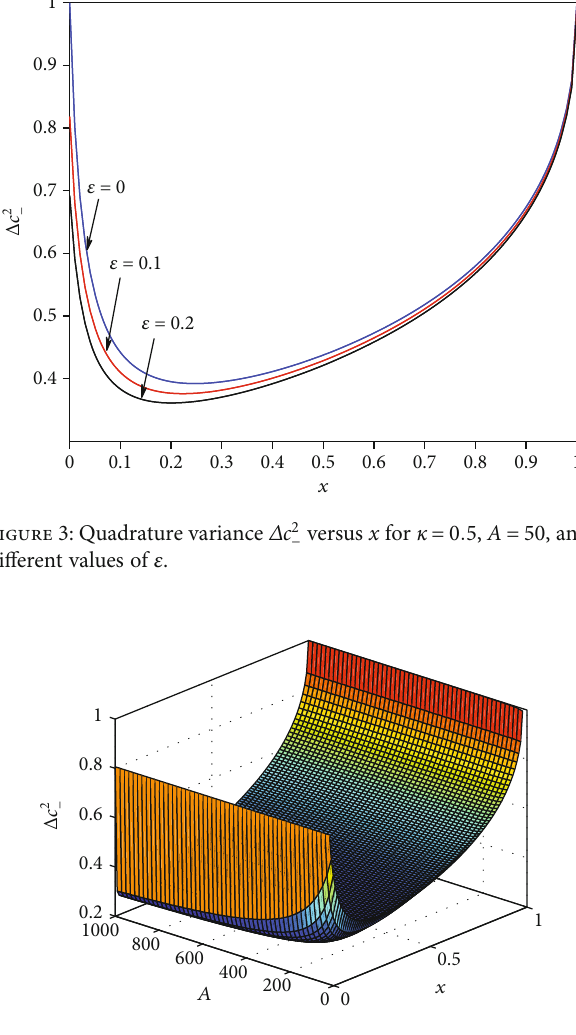
Figure 4: Quadrature variance Δ c 2 A and initial preparation of atoms x for κ = 0 : 5 and ε = 0 : 06